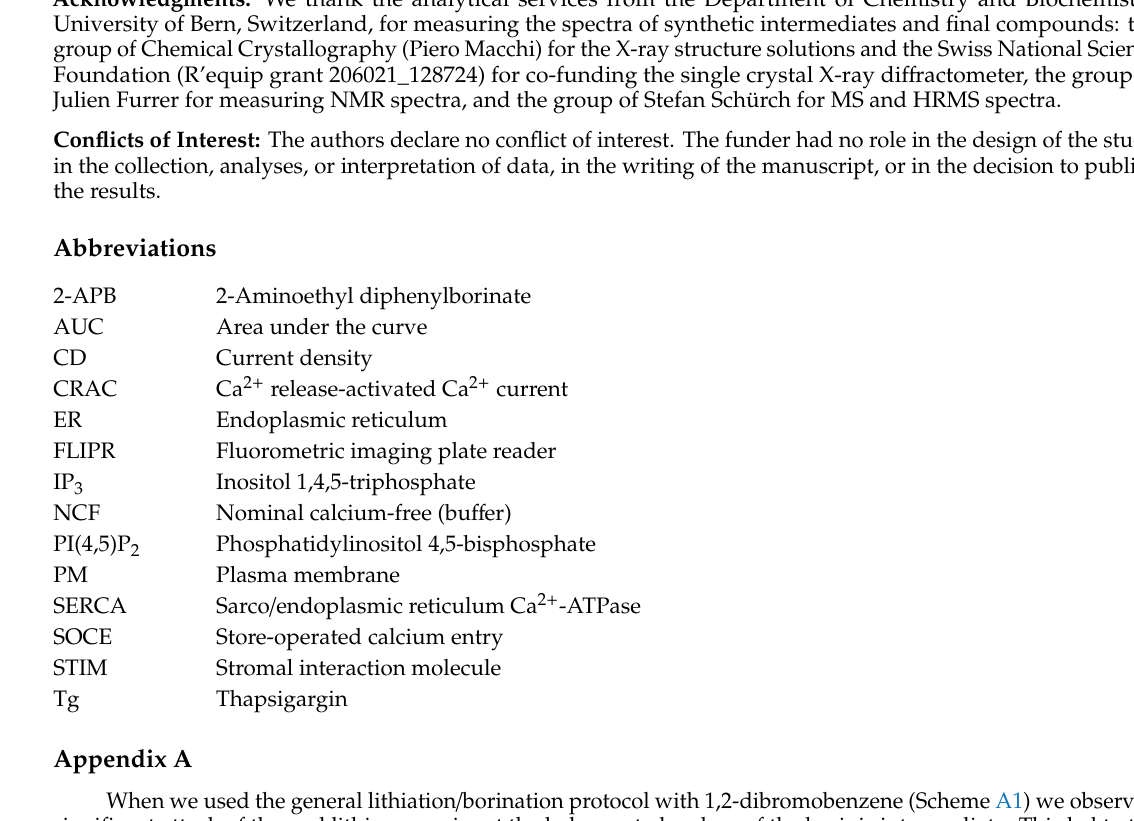
(Figure S6), SOCE in STIM1 KO and Orai1 KO cells (Figure S7) and copies of 1 H, 11 B, 13 C, and 19 F NMR spectra of all final